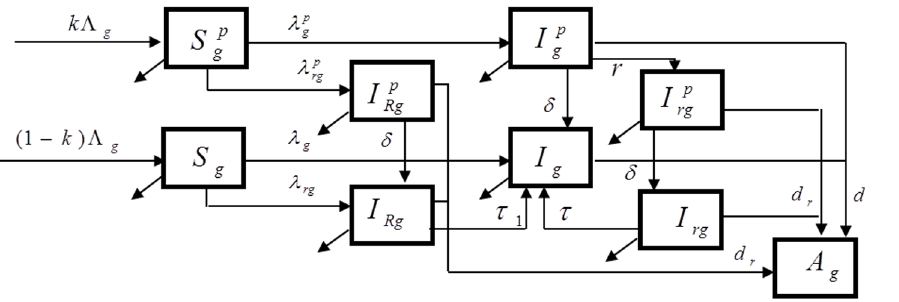
Figure 1. Flow diagram of the model. Simulated population is stratified in compartments by gender as men (subscript g=m) or women (subscript g=w) and by HIV status as susceptibles (S), infected with wild HIV (I), infected with drug-resistant HIV through transmission (I R ), individuals who developed (acquired) resistance on PrEP (I r ) and AIDS (A). PrEP users (superscript p) strictly follow the prescribed daily regimen but drop out (at rate d ) if tested HIV positive. A complete description of the model including the expressions for the forces of infections ( l ) is presented in File S1.